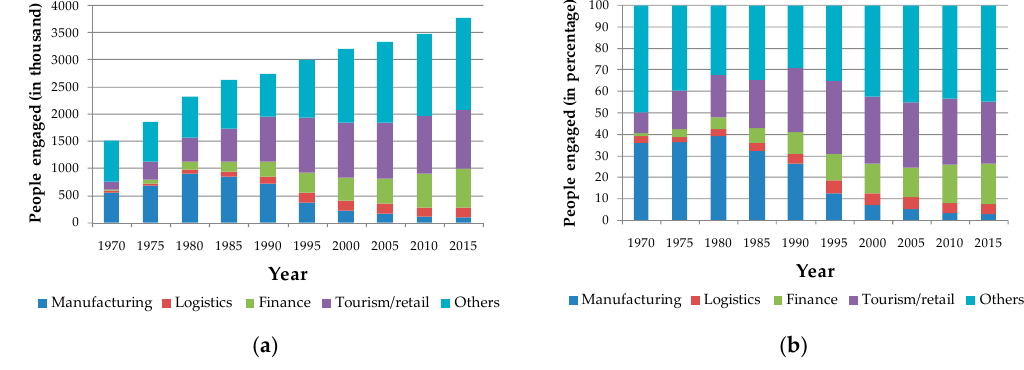
Figure 2. ( a ) People engaged in different sectors (thousands) for the period from 1970 to 2015; ( b ) people engaged in different sectors (in percent) for the period from 1970 to 2015. Note: The data were obtained from the Hong Kong Census and Statistics Department [9,27].